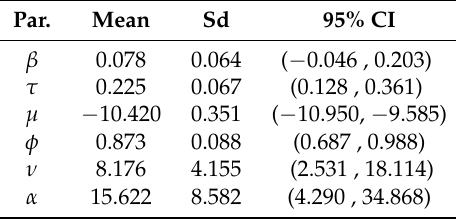
Table 4. Summary statistics of parameters: option on the YEN–USD FX rate from WinBUGS. Par.